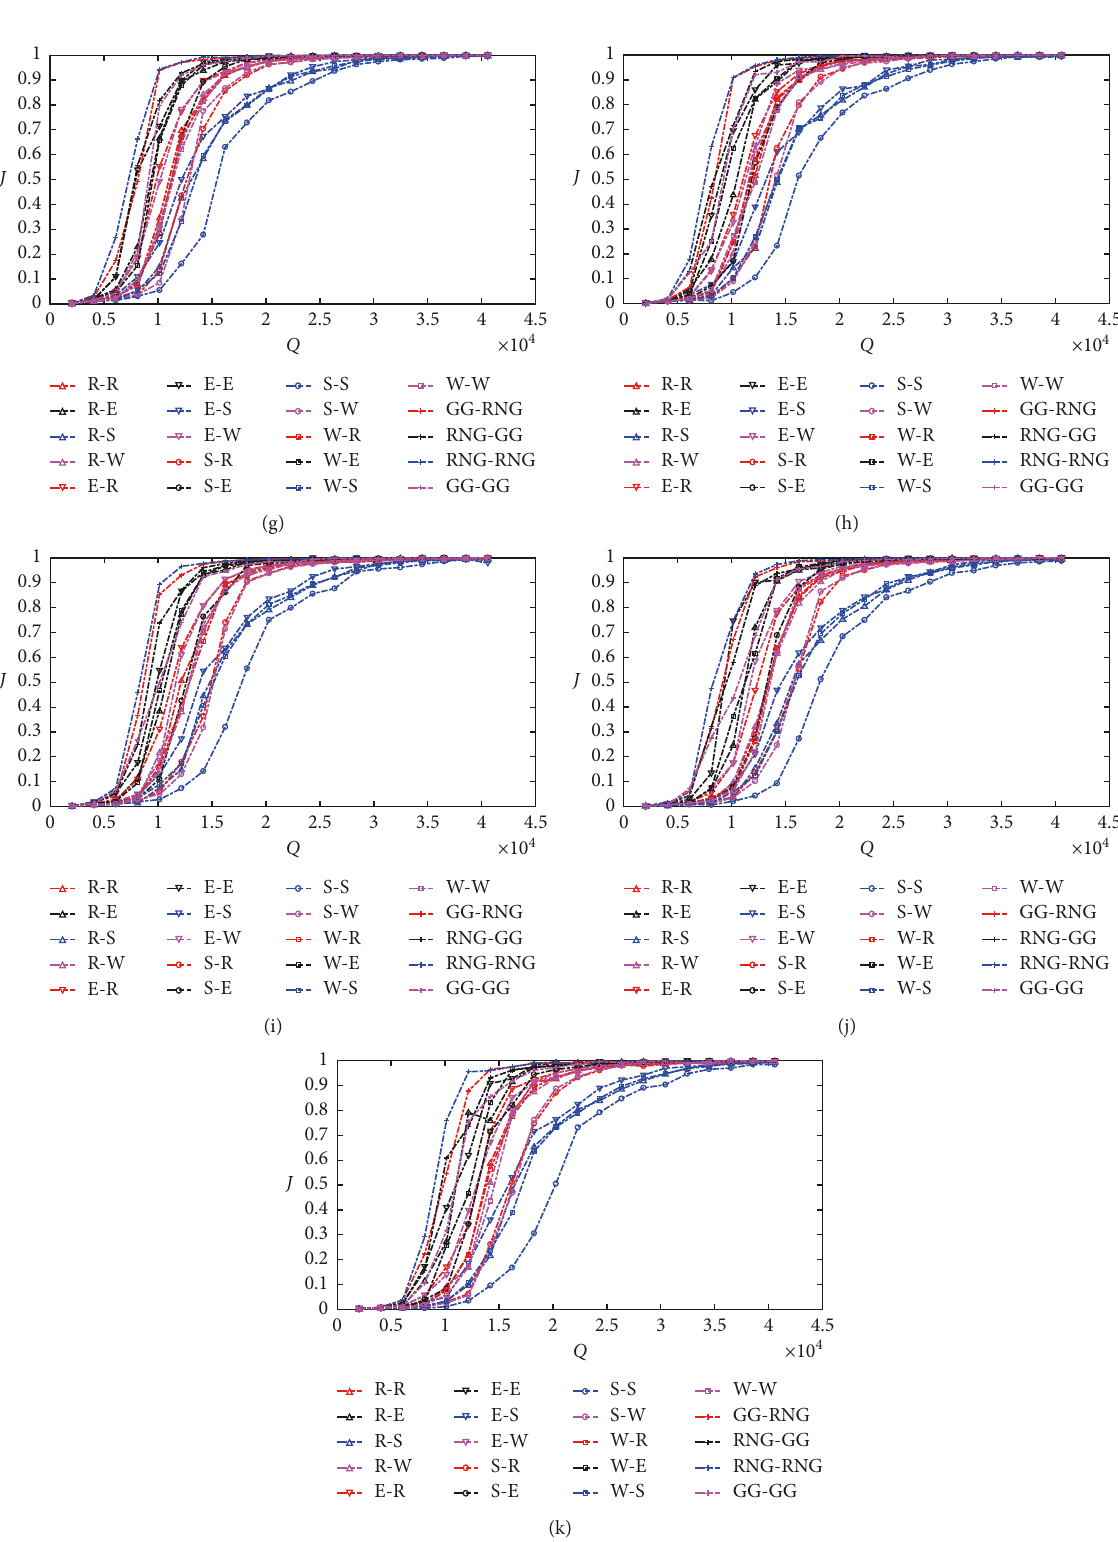
Figure 11: The influence of tunable parameter τ on multilayer networks (with the same number of nodes) when the networks are randomly connected. (a) τ � 1. (b) τ � 1 . 1. (c) τ � 1 . 2. (d) τ � 1 . 3. (e) τ � 1 . 4. (f) τ � 1 . 5. (g) τ � 1 . 6. (h) τ � 1 . 7. (i) τ � 1 . 8. (j) τ � 1 . 9. (k) τ �